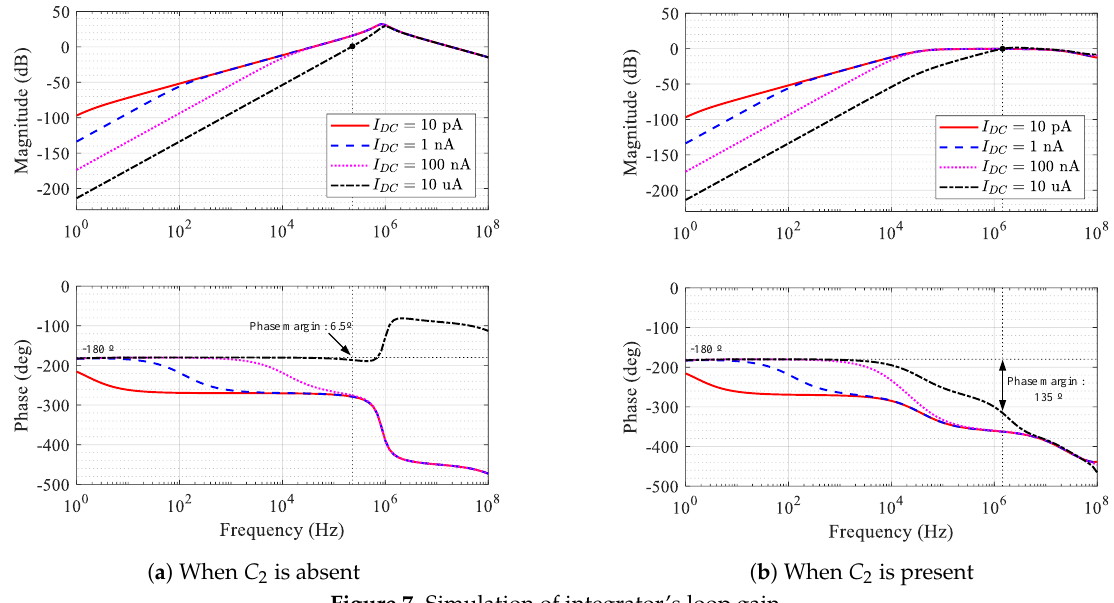
Figure 7. Simulation of integrator’s loop gain.